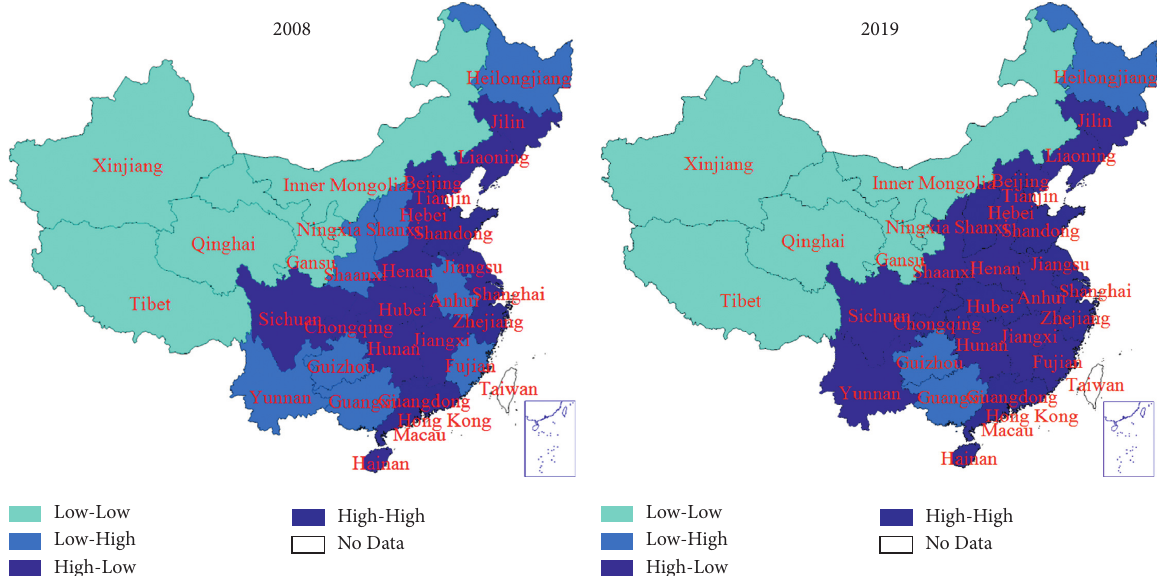
Figure 5: Regional agglomeration map of economic growth in China’s provinces in 2008 and 2019.